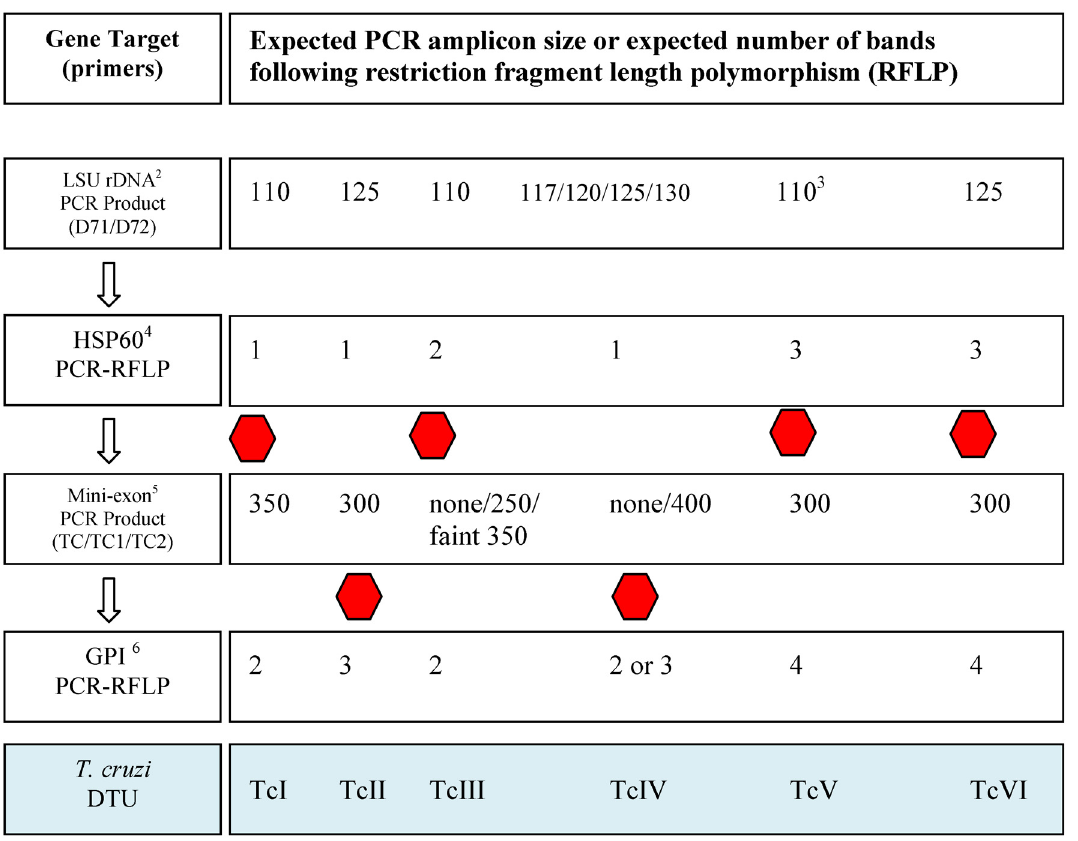
Fig 1. PCR assay flowsheet 1 to identify Trypanosoma cruzi discrete typing units (DTUs). Directional arrows indicate assay order and stop signs denote when sufficient data was gathered to theoretically identify the DTU. The final assay ( GPI ) is included as a confirmatory step, but is not required for DTU identification. 1 Modified from Lewis et al. [37] 2 The large subunit rDNA assay is also referred to as the 24s α rRNA gene assay. 3 An additional band of approximately 125bp may or may not be visible in combination with the 110bp band. 4 Heat Shock Protein-60 (HSP60) results in an amplicon of 432-462bp, which upon RFLP with Eco V restriction enzyme yields the following patterns: 1 band (432 – 462), 2 bands (118 – 148 + 314), or 3 bands (118 – 148 + 314 + 432 – 462). 5 This PCR used a pool of three primers to amplify a portion of the non-transcribed intergenic region of the tandemly repeated mini-exon gene. 6 Glucose Phosphate Isomerase (GPI) results in an amplicon of approximately 1264bp, which upon RFLP with Hha I restriction enzyme yields the following patterns: 2 bands (447 + 817), 3 bands (253 + 447 + 490), or 4 bands (253 + 447 + 490 + 817). TcIV will display 2 or 3 bands for North American and South American strains,